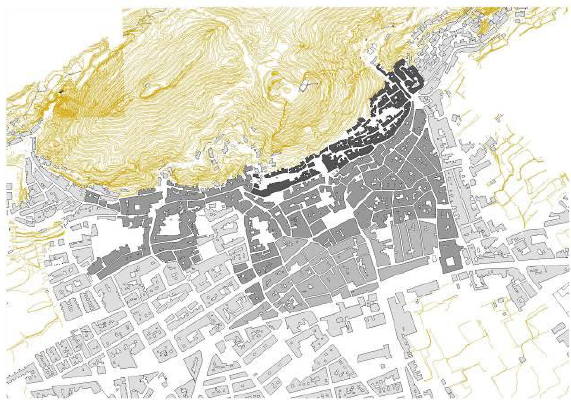
Figure 2. City plan of Mula showing the three main areas of Mula shaded: Mediaeval (black), 16th c. (dark grey) and 18th c. (light grey) (Source: Ródenas, 1991 and authors).